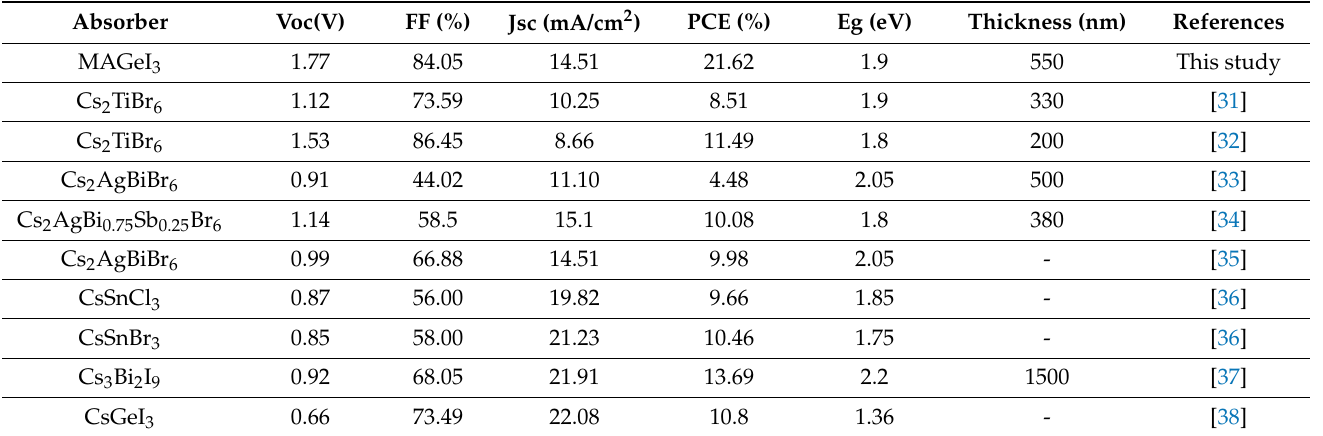
Table 1. Comparison of the efficiency of MAGeI 3 -based PSCs with recent reports [31–38].